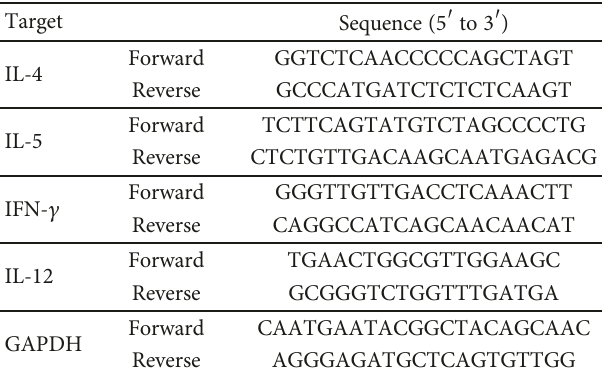
Table 1: Nucleic acid sequences of the primers used for quantitative real-time